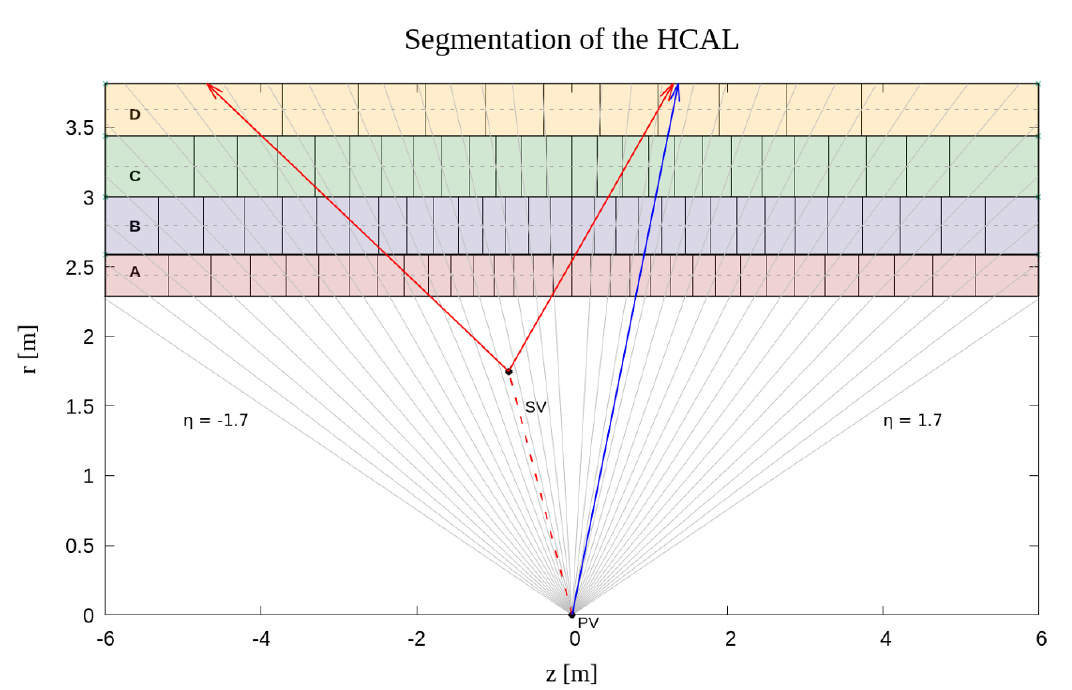
Figure 1. Simpli(cid:12)ed segmentation of the HCAL used in this work | A,B,C and D are the four radial layers extending from 2.2895 m to 3.8158 m and have a pseudorapidity coverage of j (cid:17) j < 1 : 7. Constant (cid:17) lines are shown in gray for reference. A standard particle coming from the Primary Vertex (PV) is shown in blue. A long-lived particle coming from PV and its decay products starting from the secondary vertex (SV) are shown in red. Note that the particle in blue is contained within a single (cid:17) tower (between two grey lines) whereas the particles in red are spread over several (cid:17)